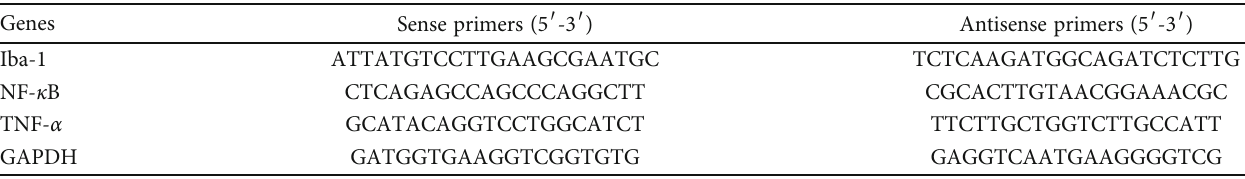
Table 1: Primers used for real-time